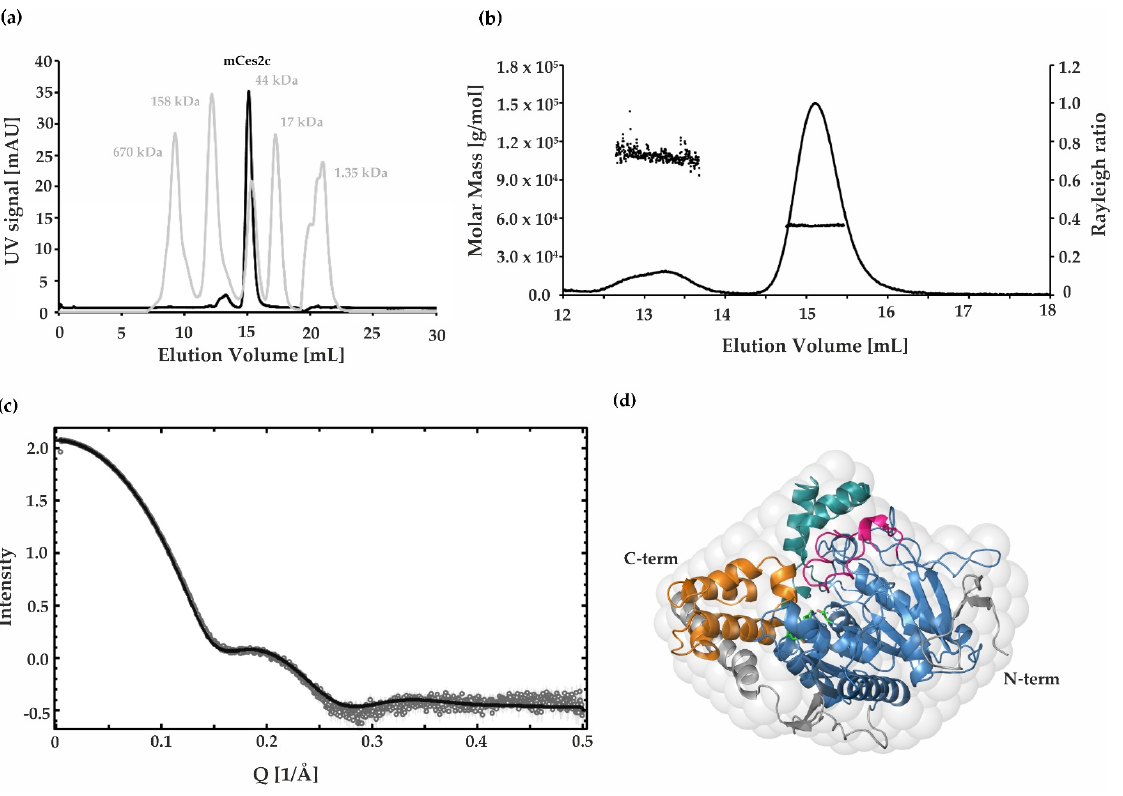
Figure 4. mCes2c is a monomer in solution. ( a ) mCes2c was analyzed using a Superdex 200 Increase analytical SEC column. The UV signal was recorded at 280 nm. Gray peaks show the elution volumes of the protein gel filtration standard from BioRad (670 kDa: thyroglobulin; 158 kDa: γ - globulin; 44 kDa: ovalbumin; 17 kDa: myoglobin; 1.35 kDa: vitamin B12). ( b ) The weight average molar mass (MW of 54.0 ± 2.4 kDa) of the dominant peak was determined by multi angle light scattering (MALS) ± standard error of mean (SEM). The very small fraction eluting at 13.2 mL likely corresponds to a dimeric form of mCes2c. ( c ) SAXS scattering curve of purified mCes2c indicates a globular monomeric protein in solution. Dmax was calculated as 83.0 Å with a radius of gyration of 24.6 Å. ( d ) A low resolution ab-initio model (gray surface) derived from the SAXS scattering curve fits very nicely to the experimentally determined 3D structure of monomeric mCes2c. All calculations and ab-initio models are obtained using the ATSAS 3.0